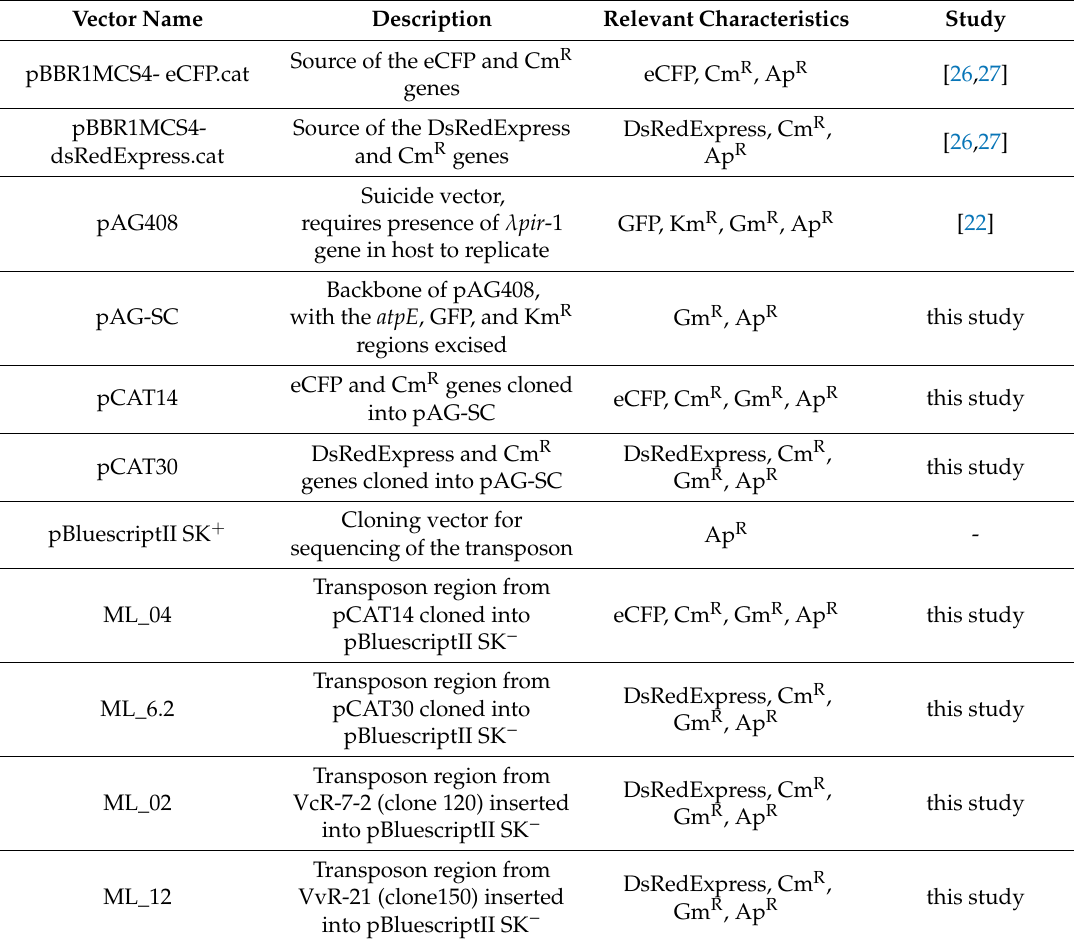
Table 2. Vectors used for Cloning and FP-labelling in E. coli and Vibrio